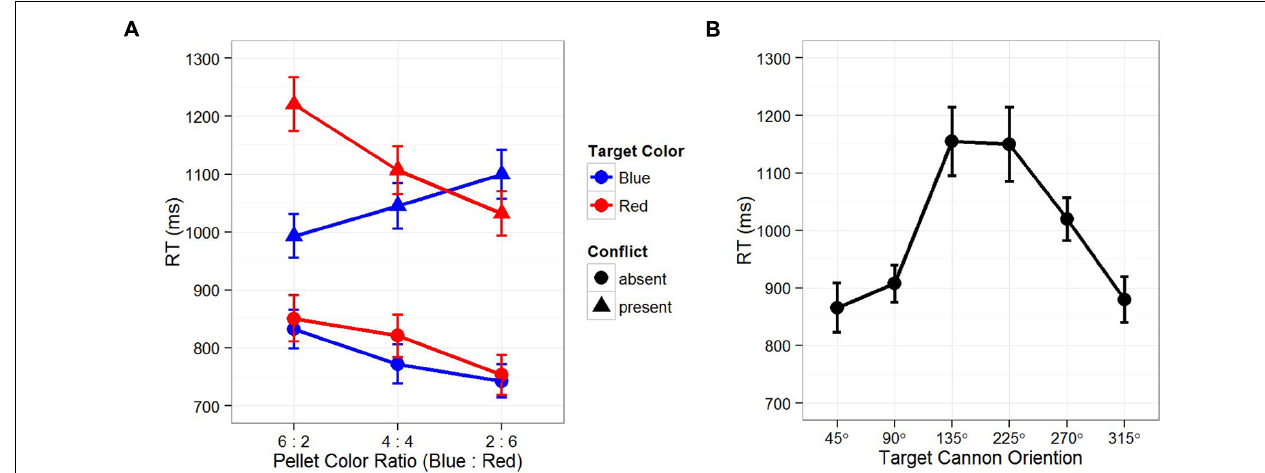
FIGURE 2 | Results fromTamborello etal. (2012). (A) Reaction times as function of target color, conflict between two cannons, and the color ratio in surrounding pellets. Across three sequentially presented blocks of trials, the surrounding pellets varied from trials of more blue pellets (B:R = 6:2) to trials of more red pellets (B:R = 2:6). Reaction times in the “conflict-absent” conditions (two cannons pointing to the same direction) were significantly faster than that those in the “conflict-present” conditions (90 or 180 ◦ between two cannons).Within the “conflict-present” conditions, reaction times were significantly faster for the cannon in the same color of the